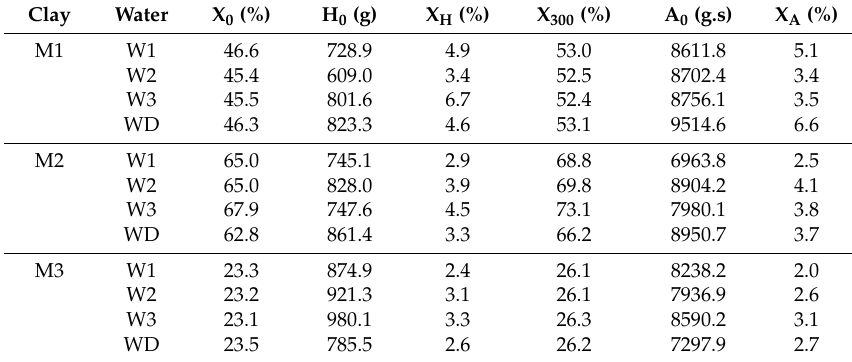
Table 4. The characteristic hardness and adhesiveness parameters of the tested products.